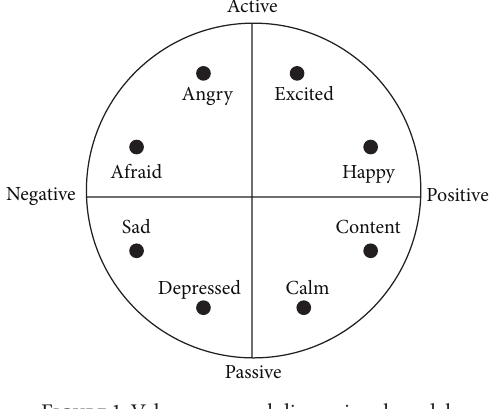
Figure 1: Valence-arousal dimensional model.